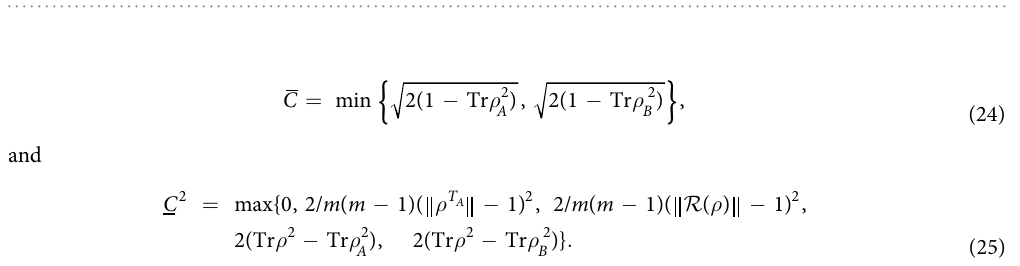
Figure 2. The plot of the second derivative of R 12 for < ≤ c 1 2/ 3